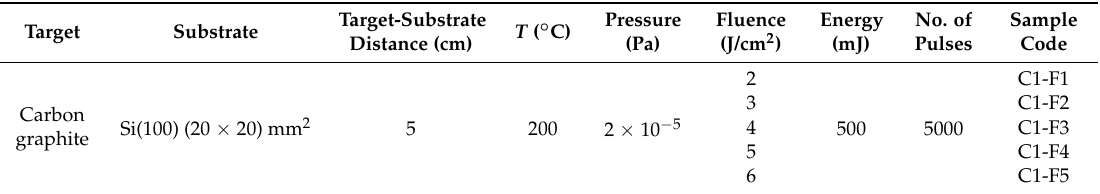
Table 1. Experimental conditions for synthesis of carbon thin films by